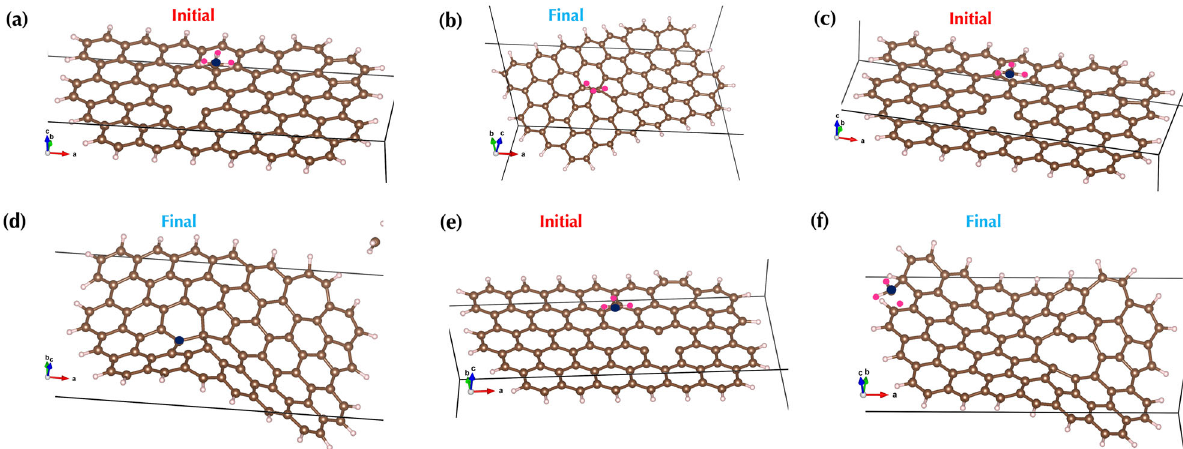
Fig. 7 Snapshots from AIMD simulations with CH3 ad-atoms performed at 300 K. Initial con fi gurations ( a , c , e ) and fi nal states ( b , d , f ) where CH 3 groups (marked with blue and pink) are added to graphene systems are shown in the fi